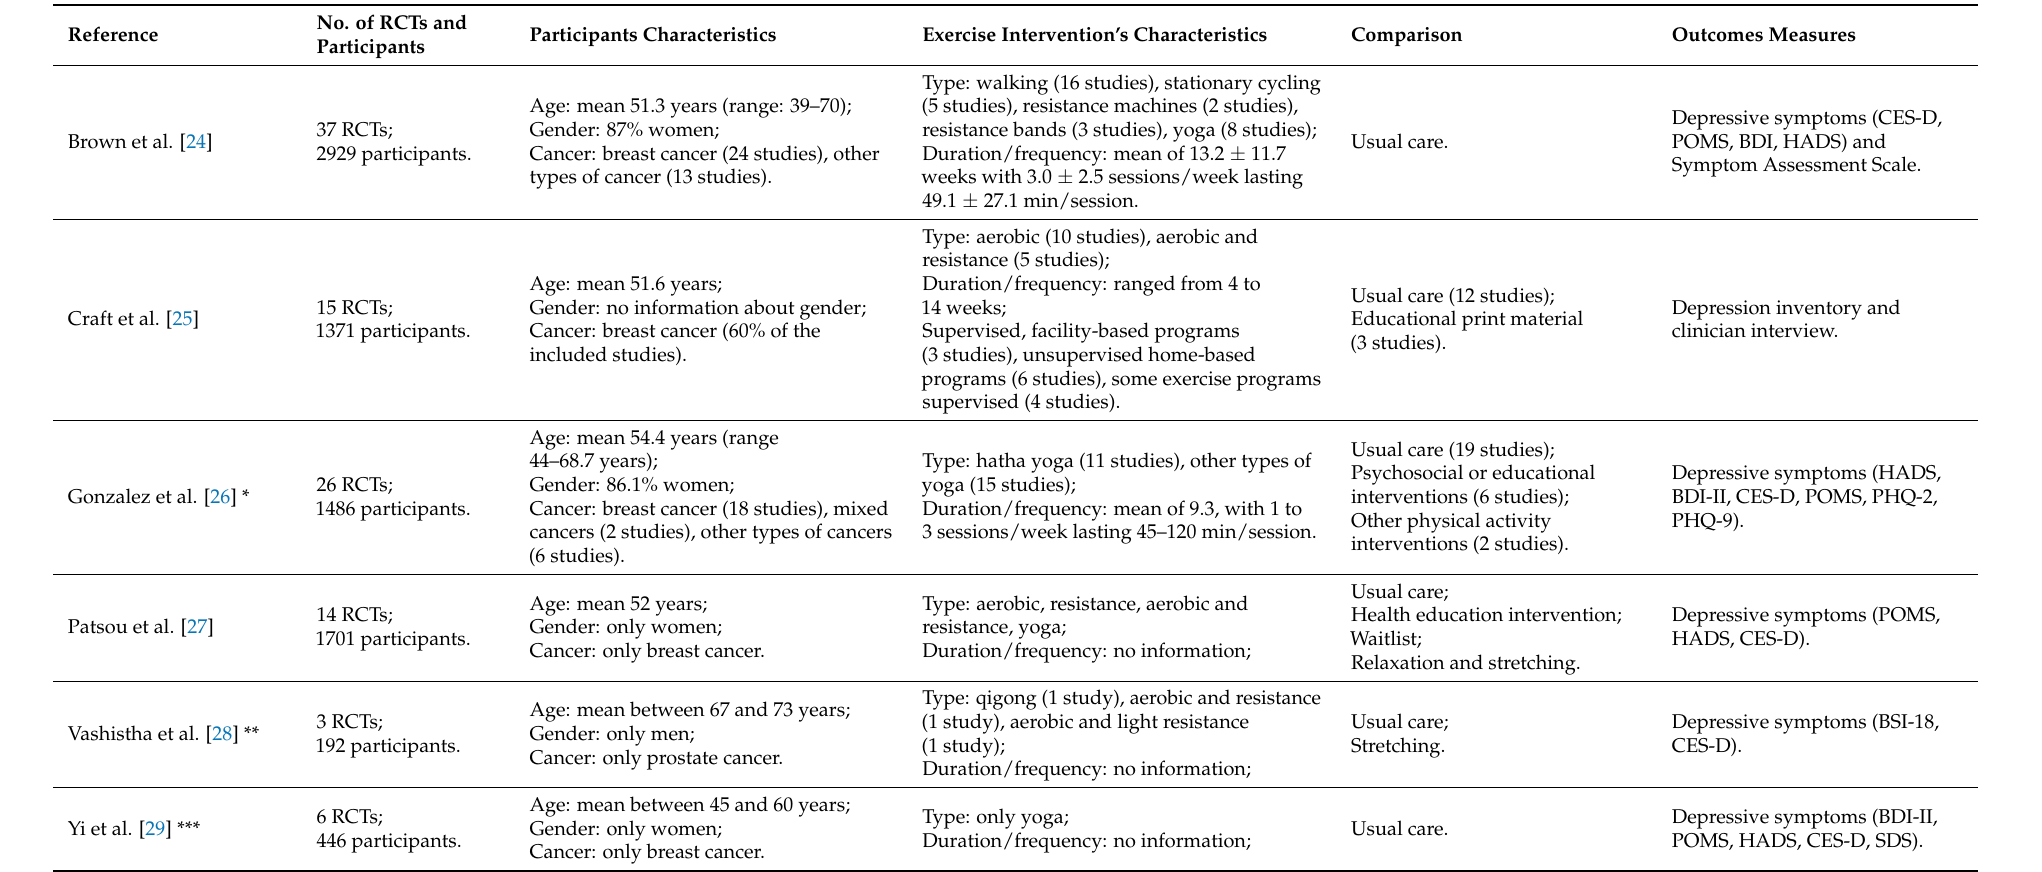
Table 1. Characteristics of the meta-analyses included in the